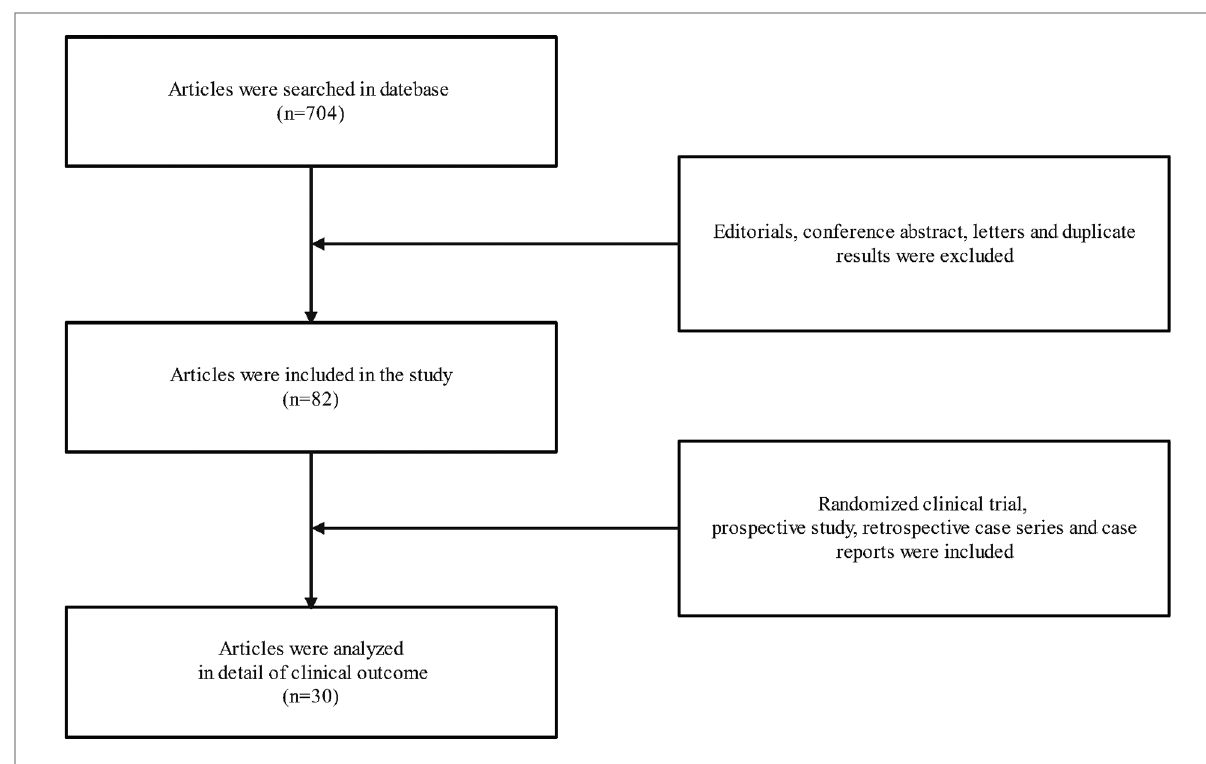
FIGURE 1 The fl ow chart of Information retrieval.